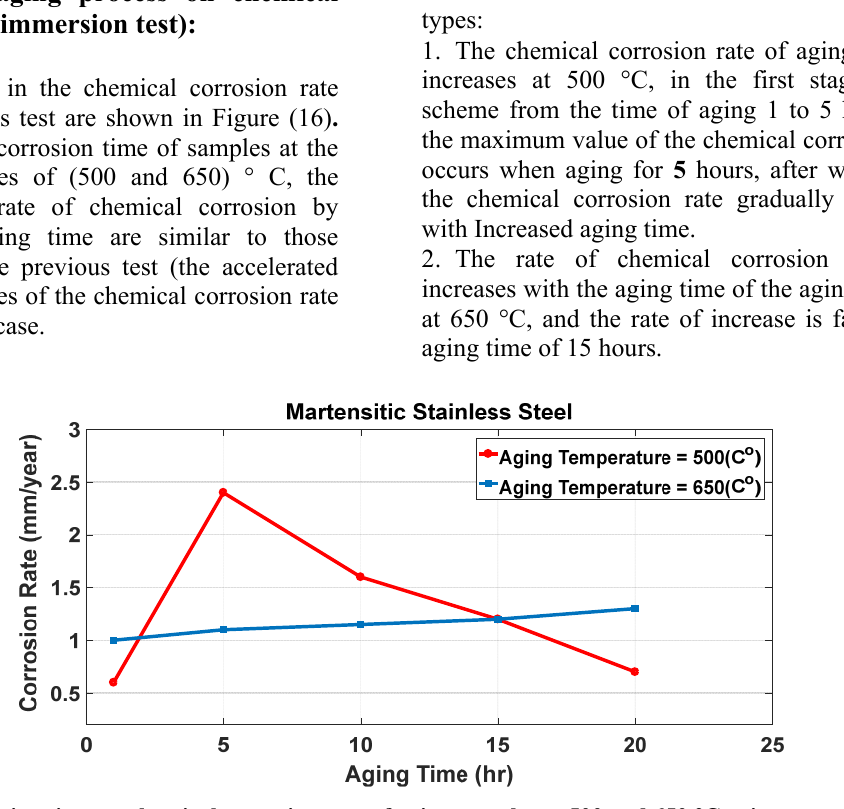
Fig. 16. Effect of aging time on chemical corrosion rate of aging samples at 500 and 650 °C aging